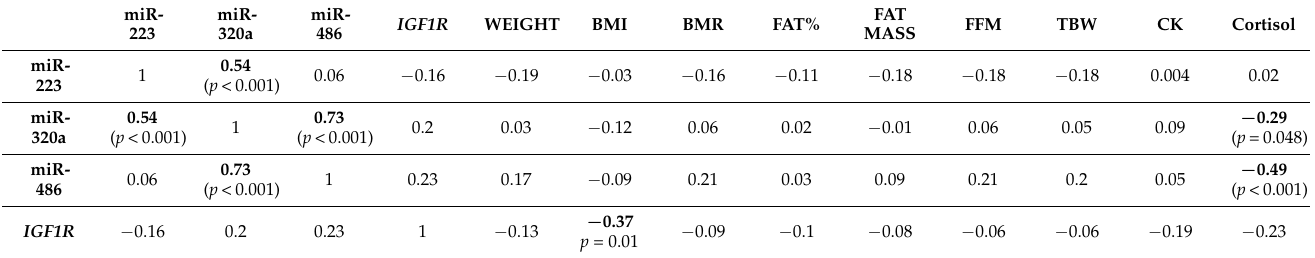
Table 3. Spearman’s rank correlation between studied markers in the whole training